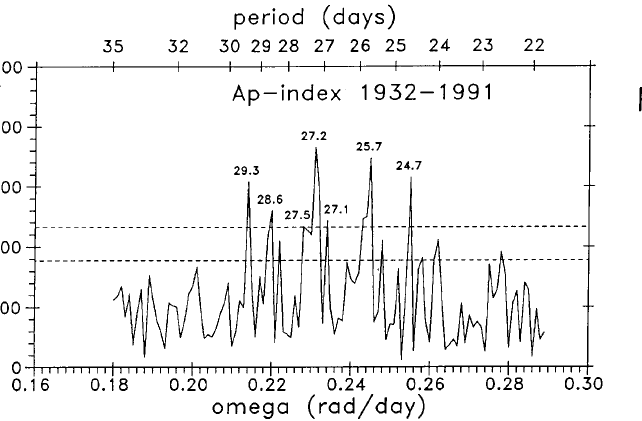
Fig. 4. Spectrum of geomagnetic Ap -indices in the whole interval 1932–1991 in the vicinity of the 27-day period. Horizontal dashed lines indicate the 95% and 99% confidence levels